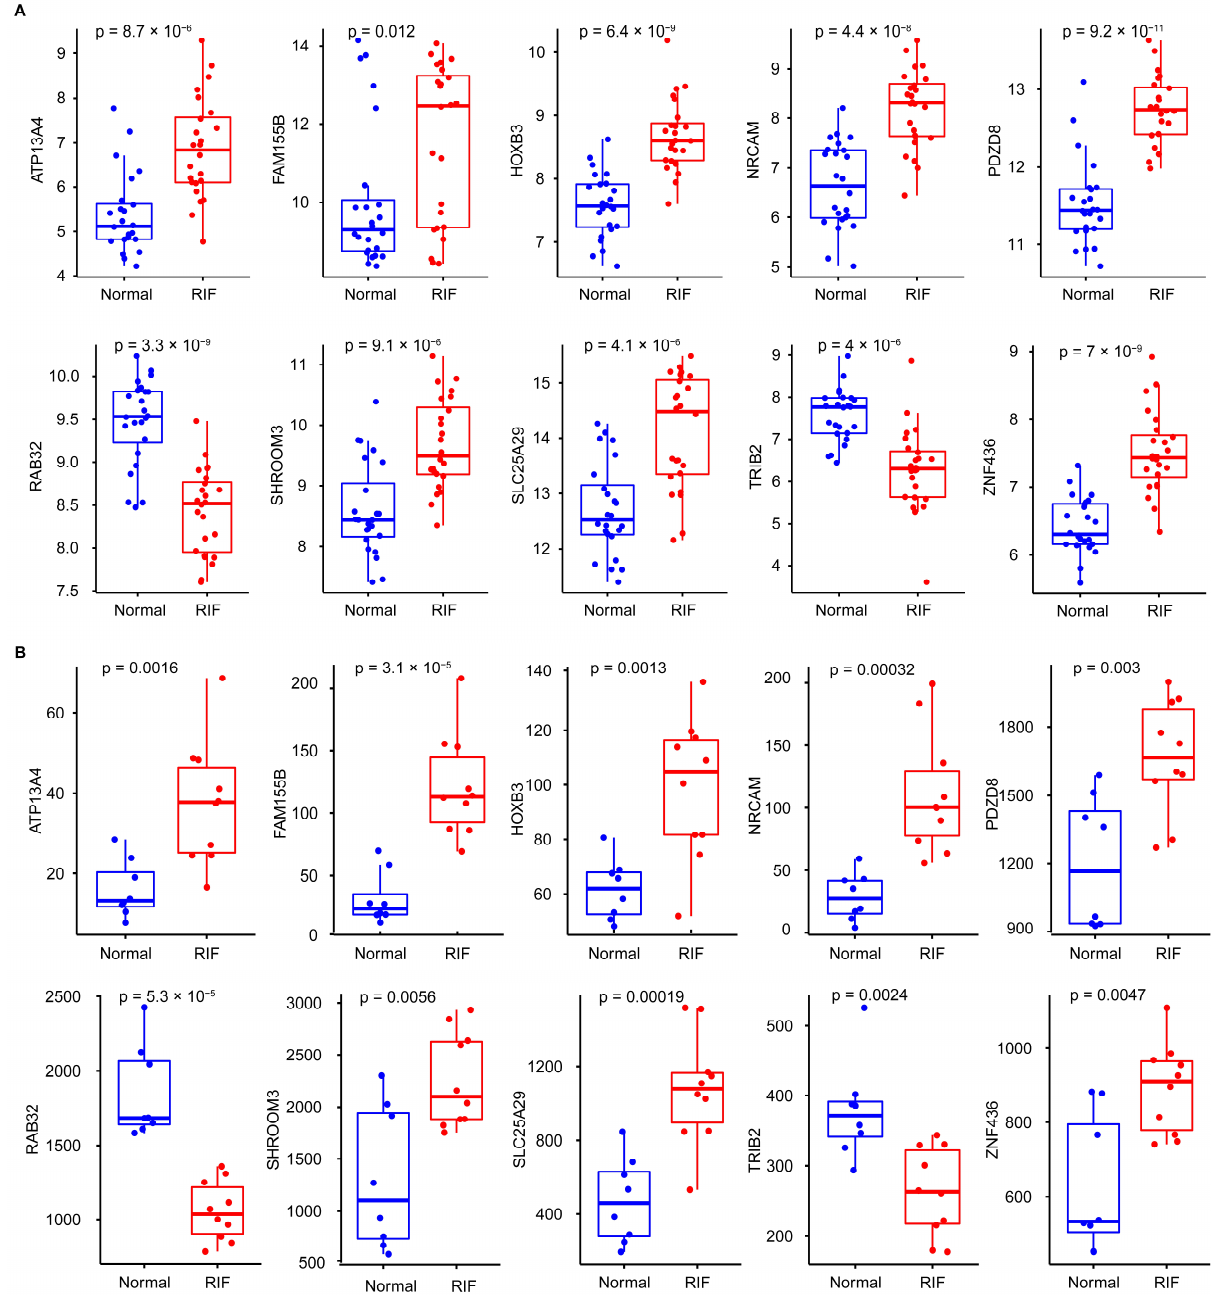
Figure 5. Identification of the hub gene expression levels. The ten hub genes in the ( A ) GSE111974 and ( B ) GSE92324 datasets. The unpaired Student’s t test was